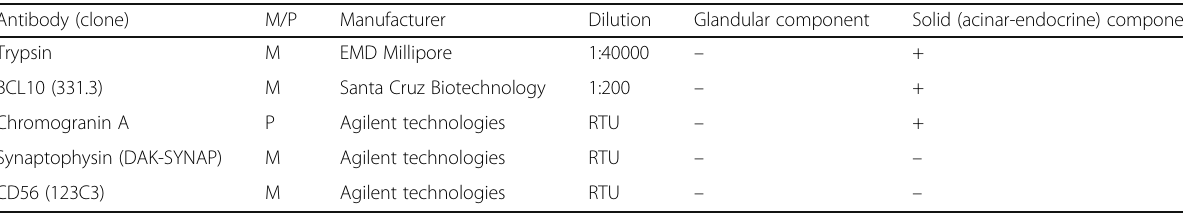
Table 1 Results of immunohistochemical